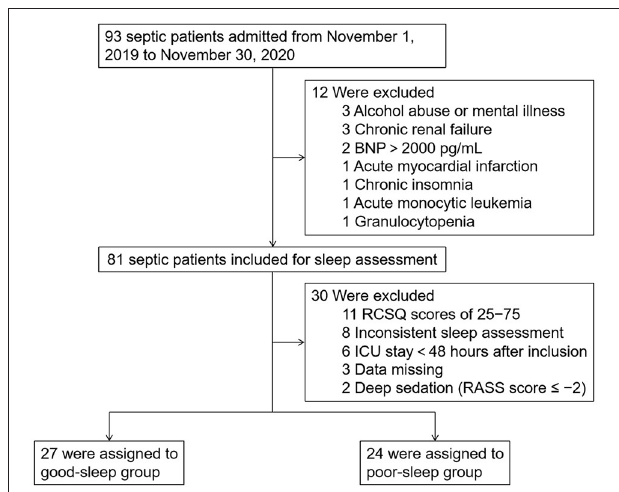
FIGURE 1 | Study flow diagram. BNP, brain natriuretic peptide; ICU, intensive care unit; RCSQ, Richards–Campbell Sleep